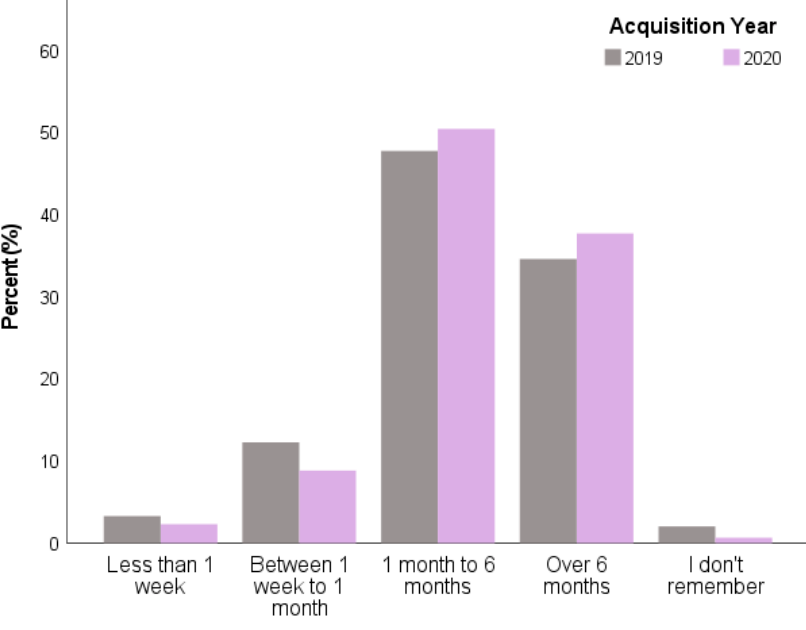
Figure 4. Interval from deciding to look for a puppy to acquisition (bringing puppy home) ( n = 5401) with comparison between 2019 owners ( n = 1124) and Pandemic Puppy owners ( n = 4277) in the UK. At the univariable level, Pandemic Puppy owners were more likely to put down a deposit before they saw their puppy (2019: 8.9% vs. 2020: 17.2%; X 2 = 81.87, df = 5, p < 0.001), and less likely to never be asked to put down a deposit for their puppy at any point during the puppy-purchasing process (2019: 37.5% vs. 2020: 28.6%) (Figure 5).